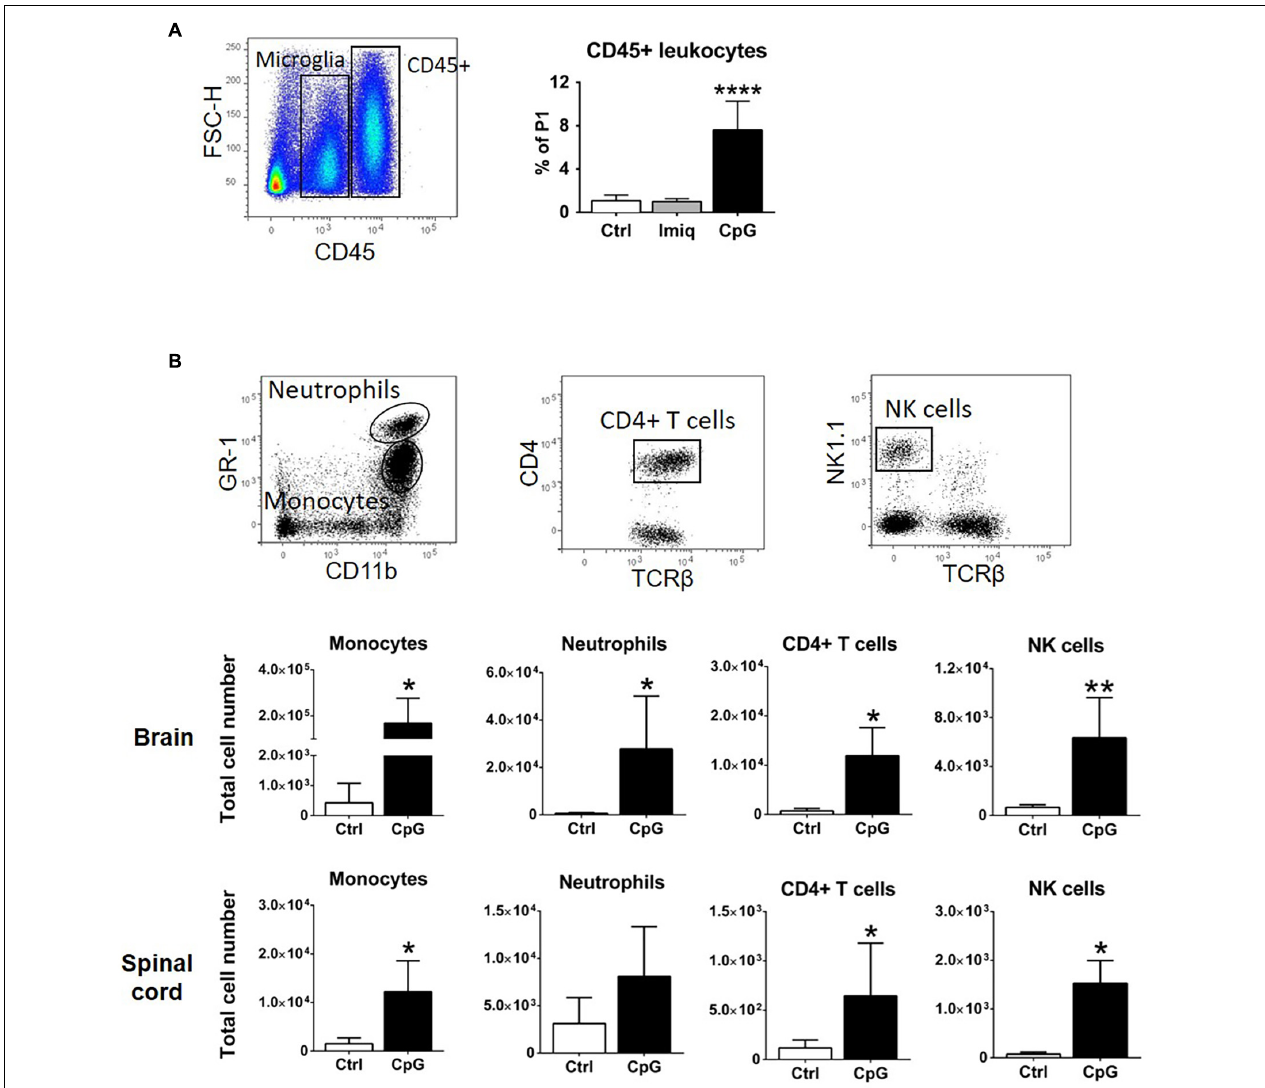
FIGURE 4 | Intrathecal CpG induced recruitment of immune cells to the healthy CNS. (A) Flow cytometric gating strategy used to distinguish CD45+ leukocytes from CD45dim microglia. The bar graph shows that intrathecal CpG but not Imiquimod (Imiq) significantly increased the number of CD45+ cells in the CNS (pooled brain and spinal cord) 4 h post injection ( n = 5–7 per group). Results were analyzed using one-way ANOVA with Bonferroni’s multiple comparisons test. (B) Representative flow cytometry profiles showing gating strategies to distinguish monocytes (CD45 hi CD11b hi GR1 low / - F4/80 + ), neutrophils (CD45 hi CD11b hi GR1 hi F4/80 - ), CD4+ T cells (CD45 hi CD11b low / - TCR β + CD4 + ), and NK cells (CD45 hi CD11b low / - TCR β - NK1.1 + ). Bar graphs show numbers of cells 24 h post injection in brains and spinal cords ( n = 4–6 per group). Results were analyzed using the two-tailed Mann–Whitney U -test. Data are presented as means ± SD. * p < 0.05; ** p < 0.01; **** p < 0.0001.